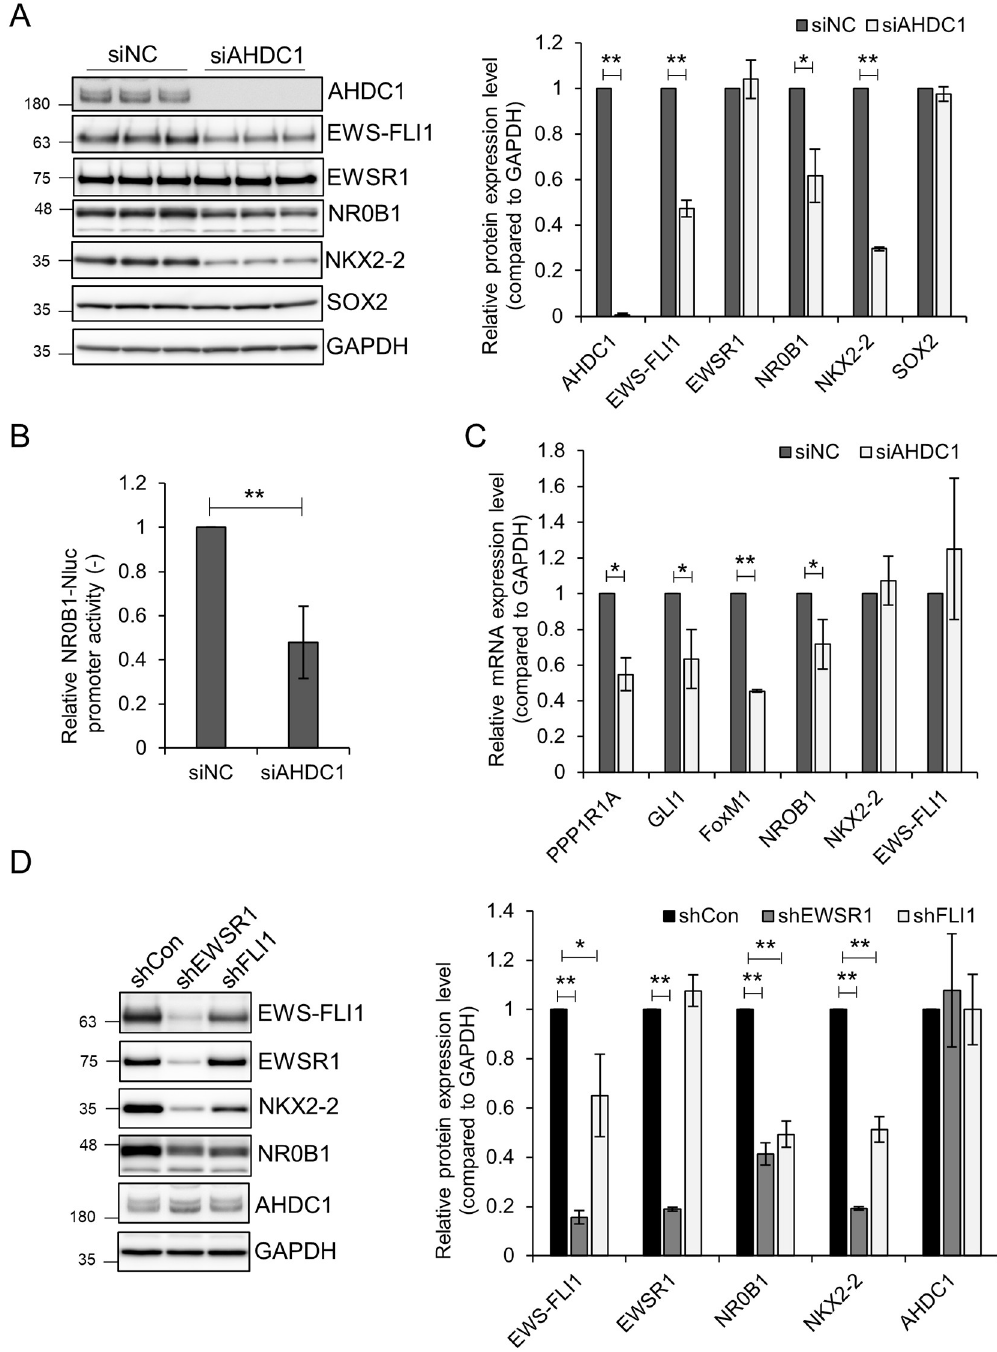
Fig 3. AHDC1 knockdown reduces gene expression of EWS-FLI1 protein. (A) siAHDC1-treated A673 cells were cultured for 2 d. Each protein was detected by its respective antibody. (B) NR0B1 promoter-Nluc plasmid was transfected into A673 cells, incubated for 4 h, and treated with siRNA for 2 d. The Nluc activity was measured by a Nono-Glo Live-cell assay system (C) siAHDC1-treated A673 cells were collected, total RNA was purified, and reverse-transcribed to cDNA. Each gene was quantified by the respective primer set using RT-qPCR. (D) Lentivirus expressing each shRNA was transduced into A673 cells for 3 d. GAPDH was used to normalize the relative values of western blotting and RT-qPCR. Three independent experiments quantified western blotting or RT-qPCR. Five independent experiments quantified the Nluc assay. P values were calculated by the student’s t-test. � p < 0.05; �� p < 0.001.